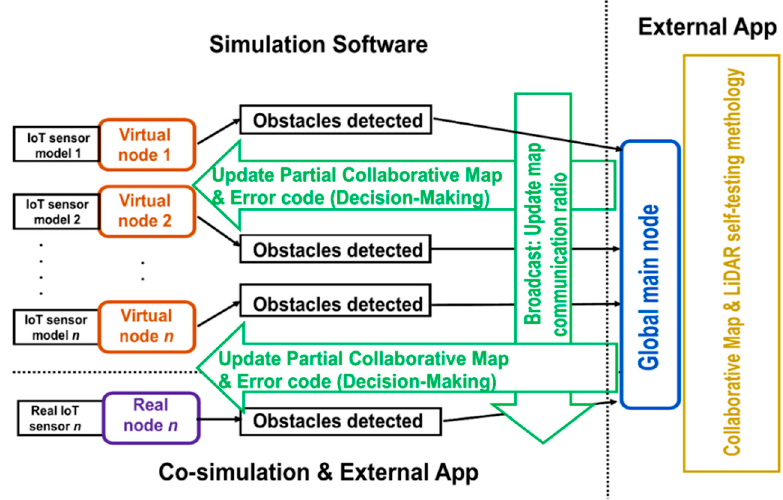
Figure 3. Conceptual flowchart showing the operation of a reliability co-simulation framework with CPS computing nodes and IoT sensors.